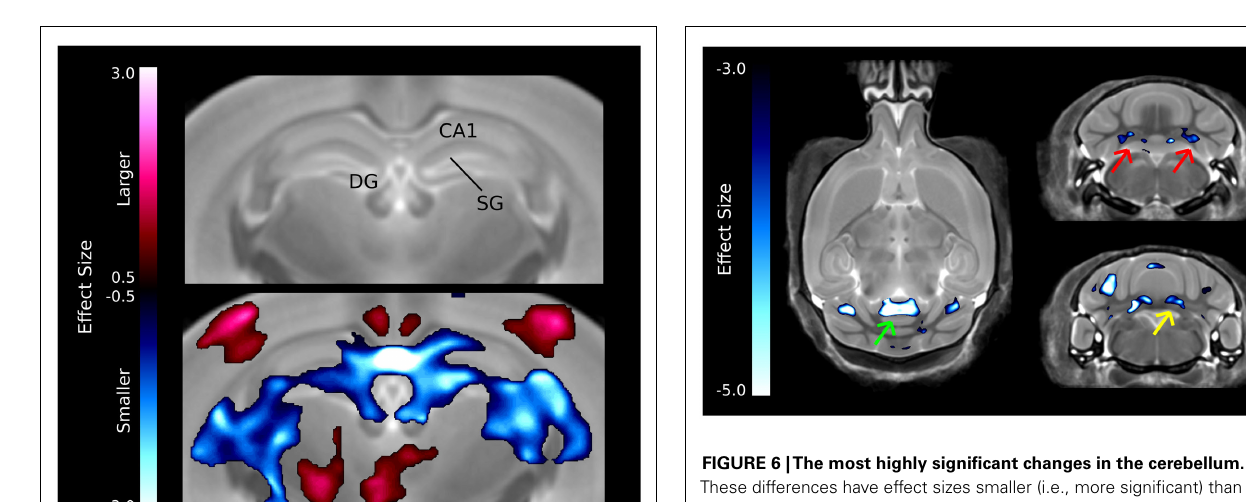
FIGURE 4 |The dorsal raphe nuclei in the ITG β 3 show a large decrease in the lateral wings located within the periaqueductal gray matter. The relative volume changes in the highlighted voxel (pink cross) are displayed in